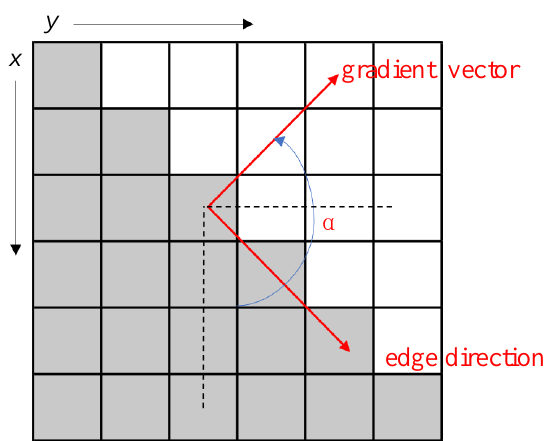
Figure 10. The gradient vector, azimuth angle and edge direction of the center point. The edge of any point is orthogonal to the gradient vector.